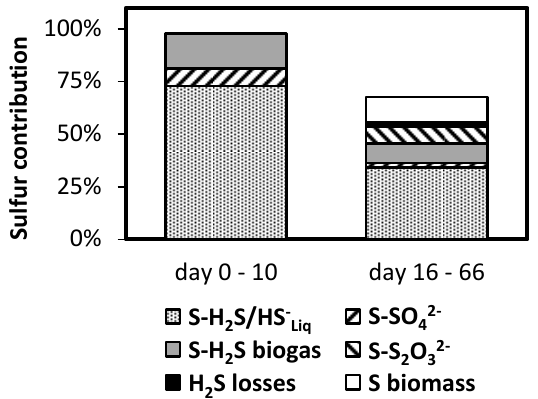
Figure 5. Cumulative contribution of different sulfur compounds to the sulfur leaving Reactor 2 during the indicated periods. Values reported as a percentage of the mass of sulfur that entered the system (as sulfate in the feed).